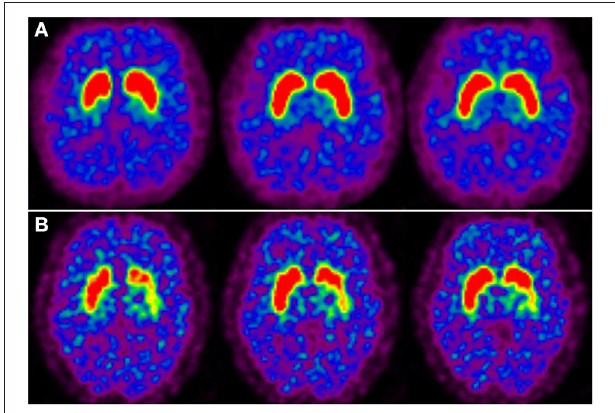
FIGURE 3 | Dopamine transporter PET imaging in moyamoya disease-induced chorea. (A) Axail 11 C-CFT PET images revealed normal bilateral 11 C-CFT uptake in the striatum of patient 1. (B) 11 C-CFT PET images revealed reduced 11 C-CFT uptake in the left striatum of patient